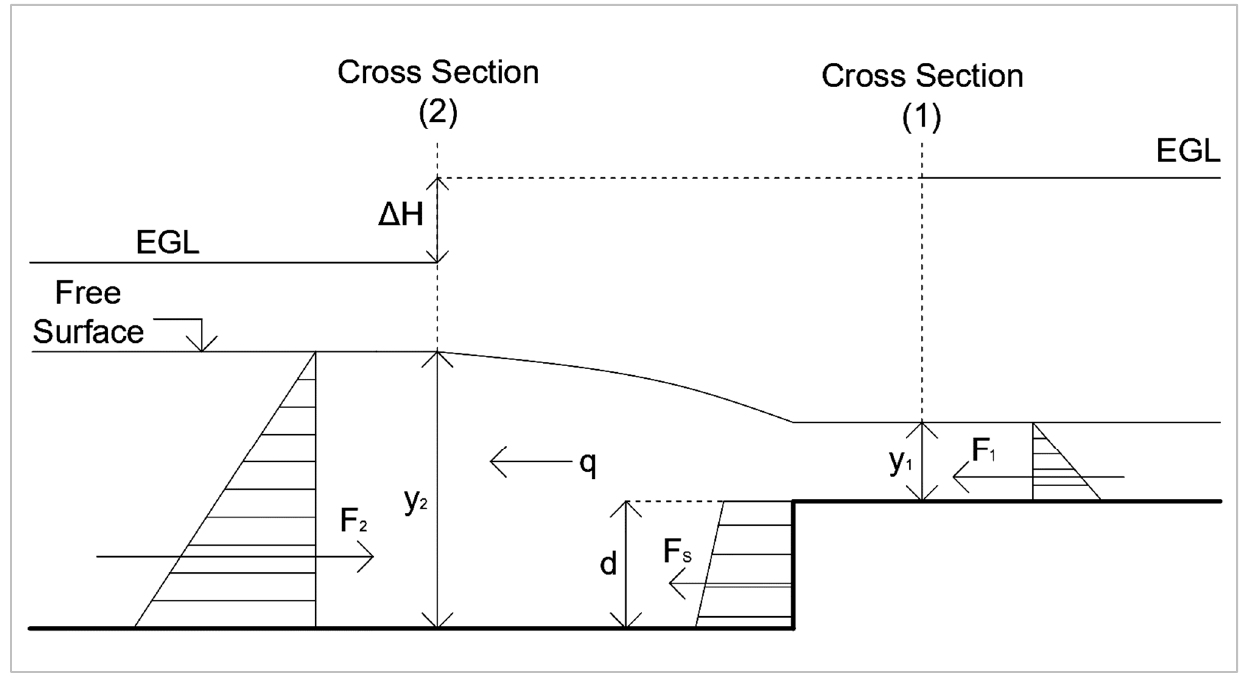
Figure 2. Definition sketch for the momentum and the energy equations.